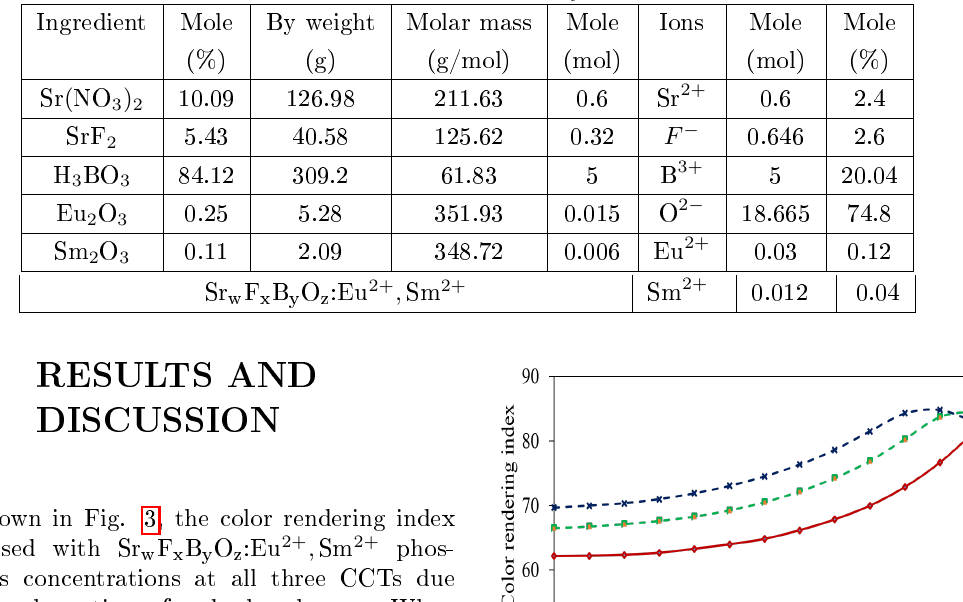
Table 1. Composition of red-emitting Sr w F x B y O z :Eu 2+ , Sm 2+ phosphor.